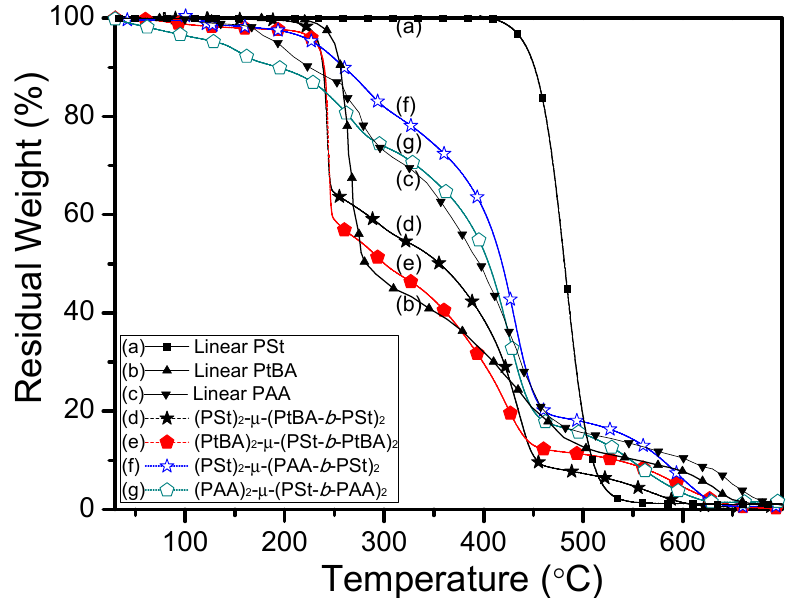
Figure 8. TGA ccurves of ( a ) linear PSt, ( b ) linear PtBA, ( c ) linear PAA, ( d ) (PSt) 2 - µ -(PtBA- b -PSt) 2 , ( e ) (PtBA) 2 - µ -(PSt- b -PtBA) 2 , ( f ) (PSt) 2 - µ -(PAA- b -PSt) 2 , and ( g ) (PAA) 2 - µ -(PSt- b -PAA) 2 µ -stars. The µ -stars were spin-coated on silicon wafers and the hydrophobicity was analyzed through water contact angle (WCA) measurements. As shown in Figure 9a,b, the WCAs of (PSt) 2 - µ -(PtBA- b -PSt) 2 and (PtBA) 2 - µ -(PSt- b -PtBA) 2 were ca. 99.9 ± 4.5 ◦ and 104.6 ± 5.6 ◦